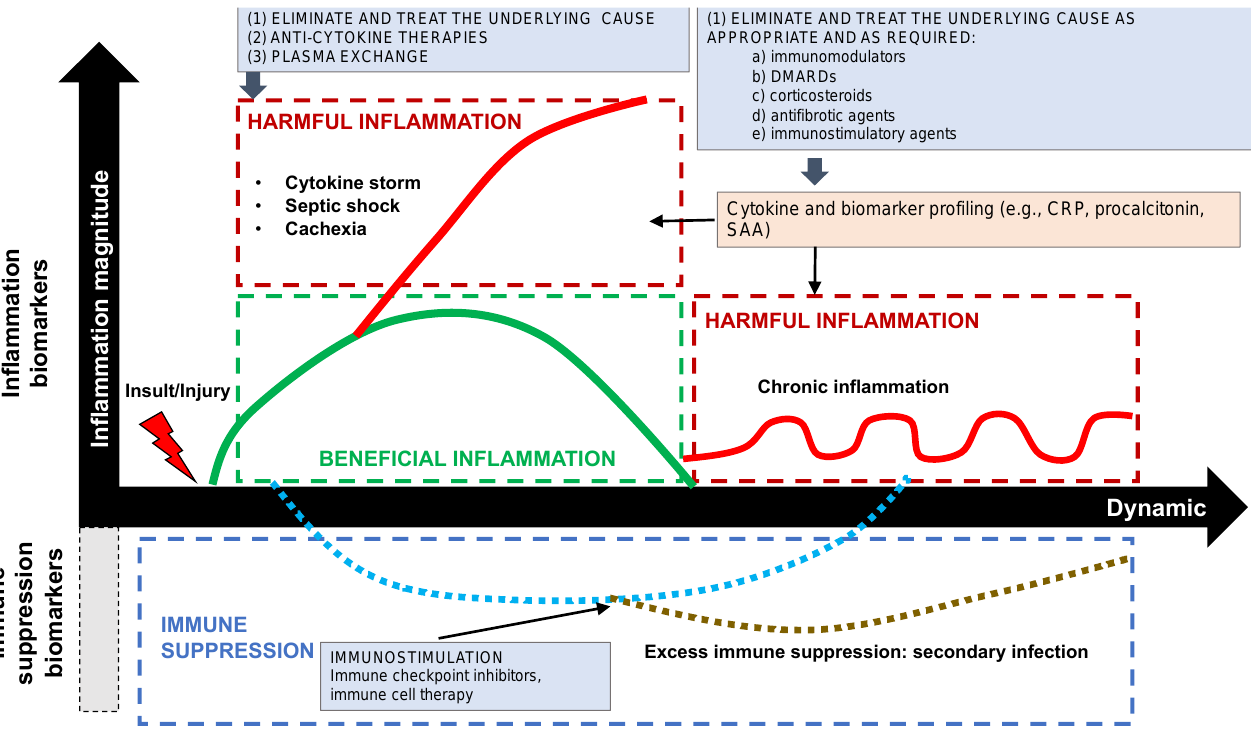
Figure 3. Potential Therapeutic Options Depending on Clinical Context Depending on Whether Hyperinflammation, Chronic Inflammation or Immunosuppression Is Present.